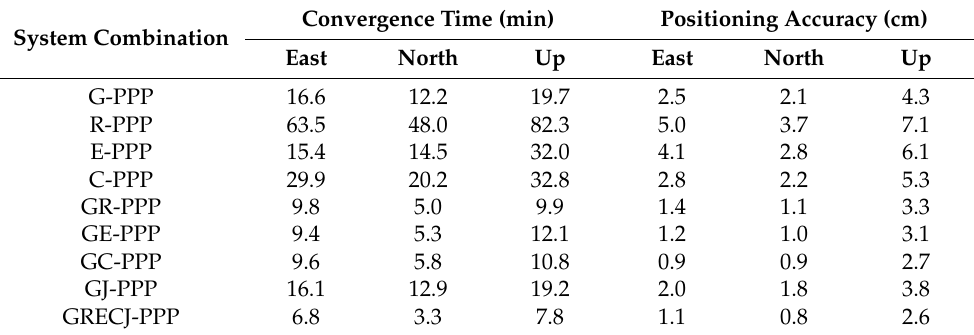
Table 15. Kinematic positioning accuracy and convergence time of post-processed PPP (long-term performance of PPP based on daily observations) with ESA products for different system combina- tions using the datasets from 29 stations spanning a